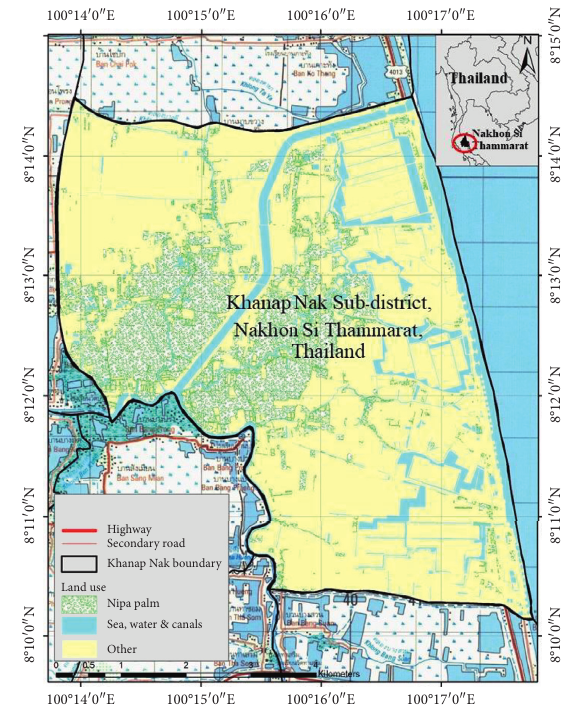
Figure 1: Khanap Nak, Nakhon Si Thammarat,